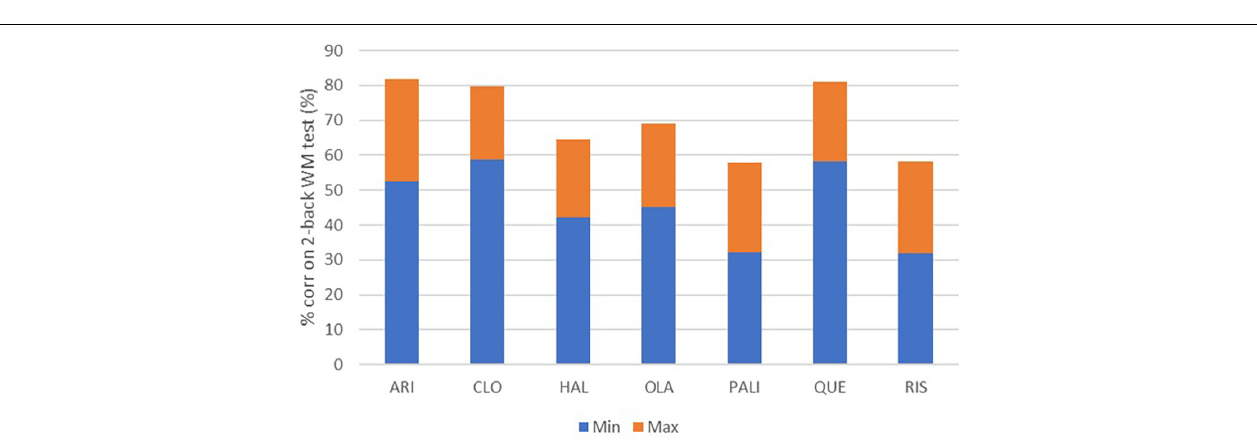
FIGURE 4 | Minimum and maximum effect of cognitive outcome on the 2-back working memory test for the different antipsychotics at the clinically most relevant dose and modulated by 9 different combinations of COMTVal158Met and 5-HTTLPR L/s genotypes. The variability can be substantial ( > 25 percentage points, a quart of the total dynamical range of the scale) for risperidone, paliperidone and aripiprazole.